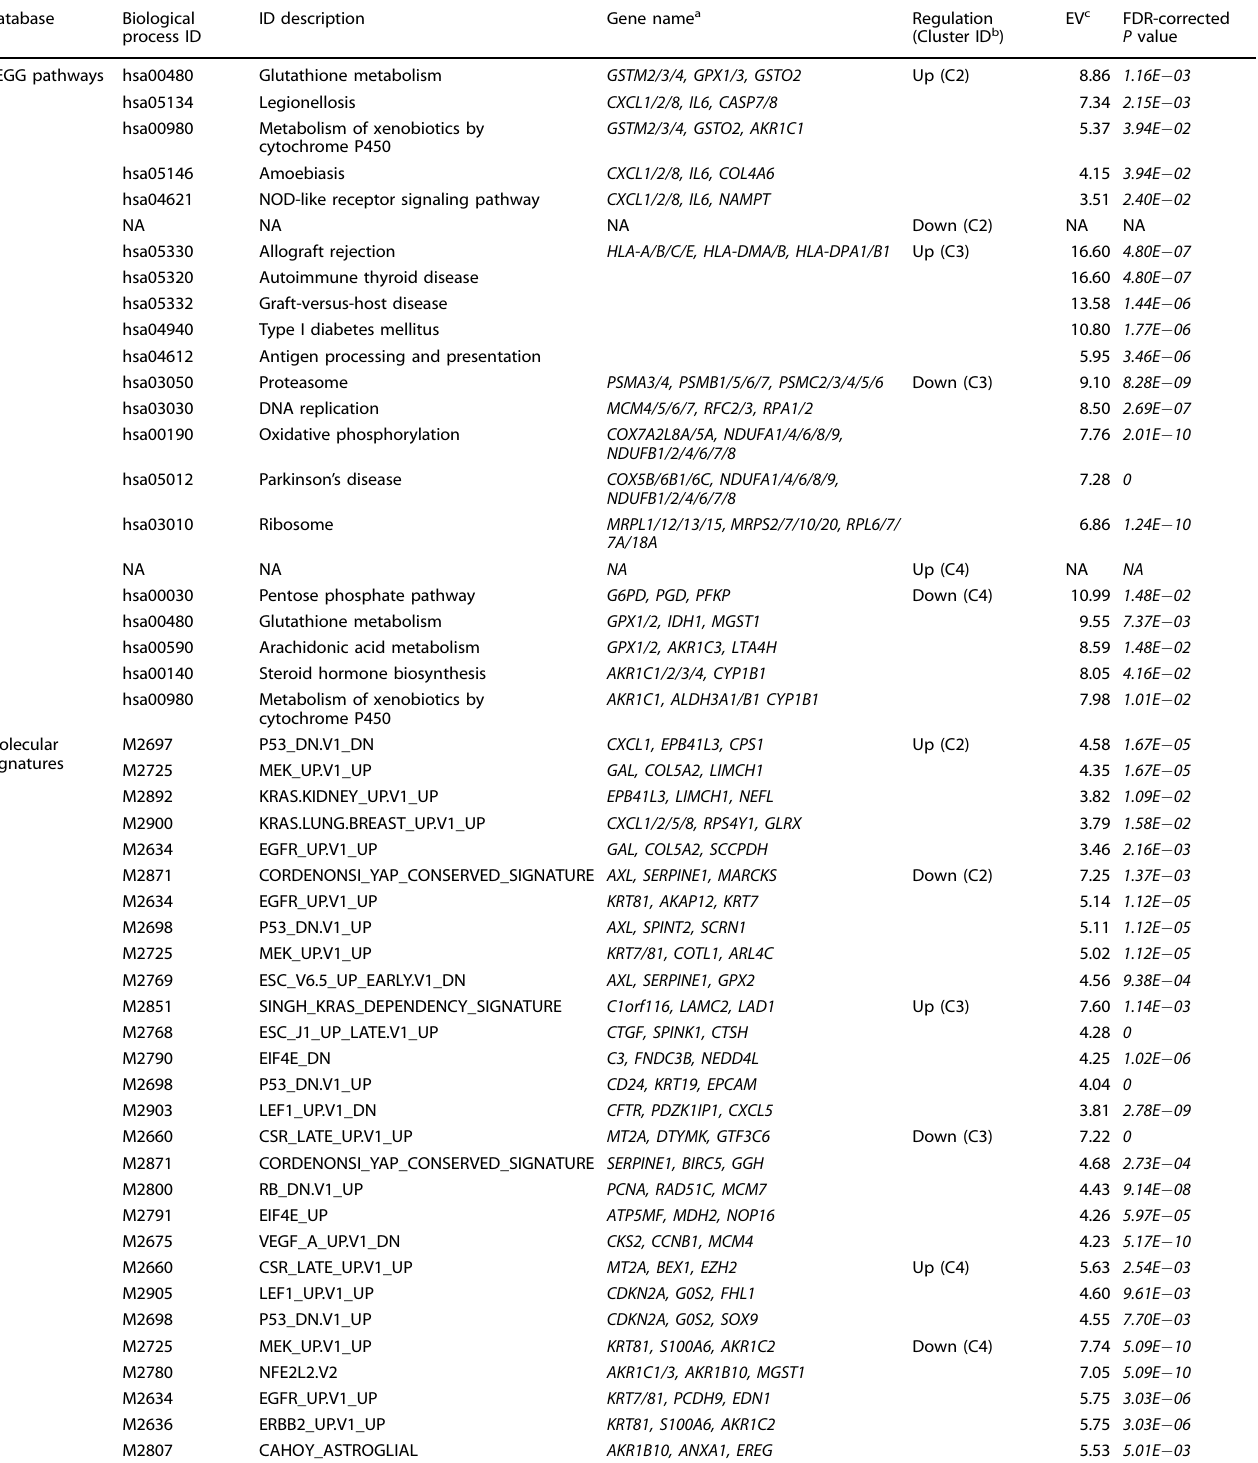
Table 1. Top fi ve KEGG pathways and molecular signatures overrepresented from GSEA.